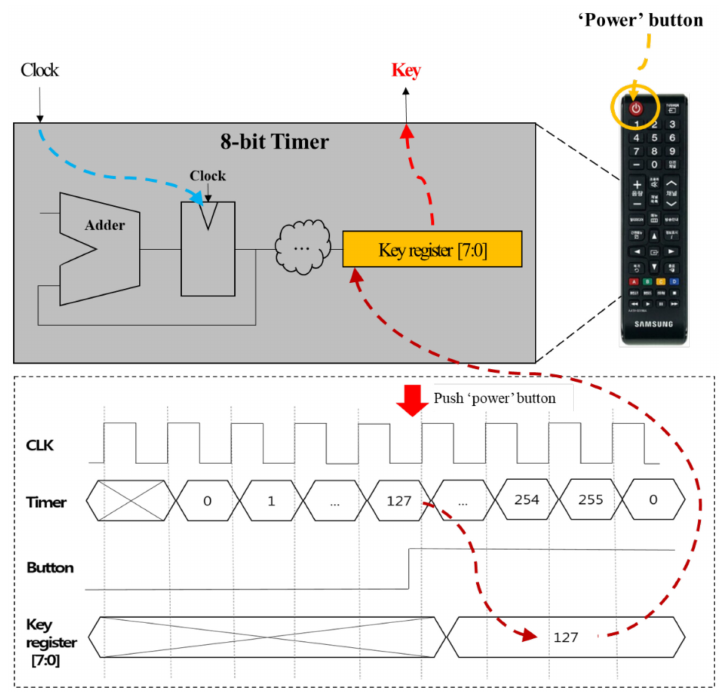
Figure 14. Key generator using 8-bit